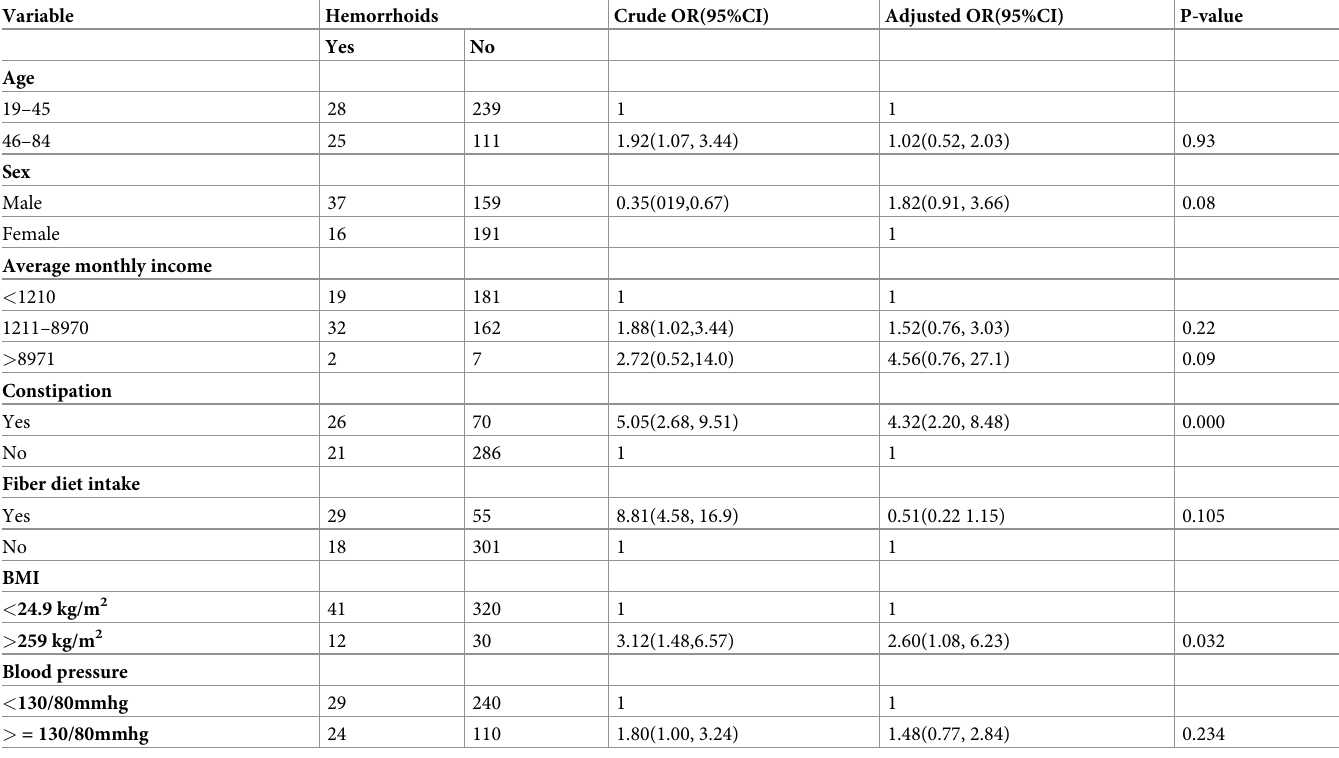
Table 3. Multiple logistic regression output for the factors associated with hemorrhoids among adult patients visiting surgical OPD at the UOG Comprehensive Hospital, Ethiopia, 2020 (n =